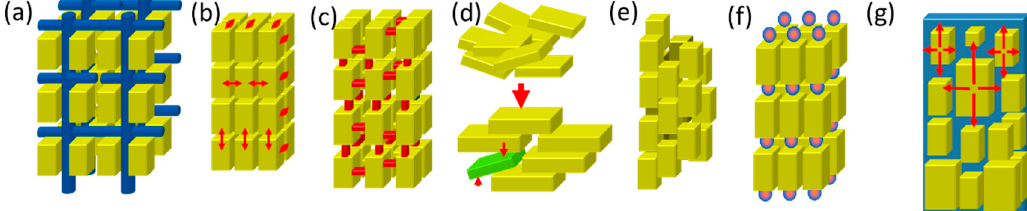
Figure 8. Simplified schematic illustration of main formation pathways of mesocrystals. ( a ) Alignment by organic matrix, ( b ) alignment by physical forces, ( c ) crystalline bridges, epitaxial growth and secondary nucleation, ( d ) alignment by spatial constraints, ( e ) alignment by oriented attachment ( f ) alignment by face selective molecules and ( g ) topotactic (epitaxial) solid phase transformation.